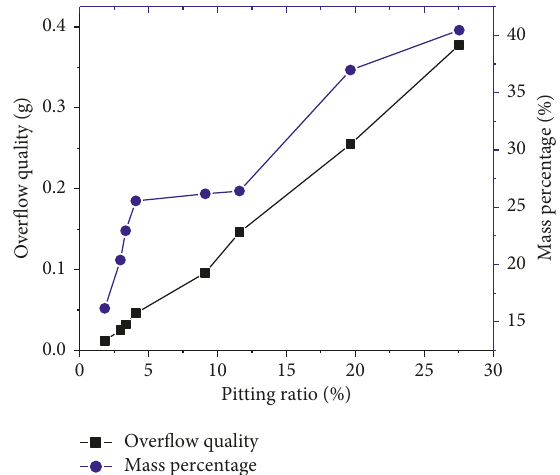
Figure 7: Variation diagram of spillage quality and mass percent change with pitting corrosion